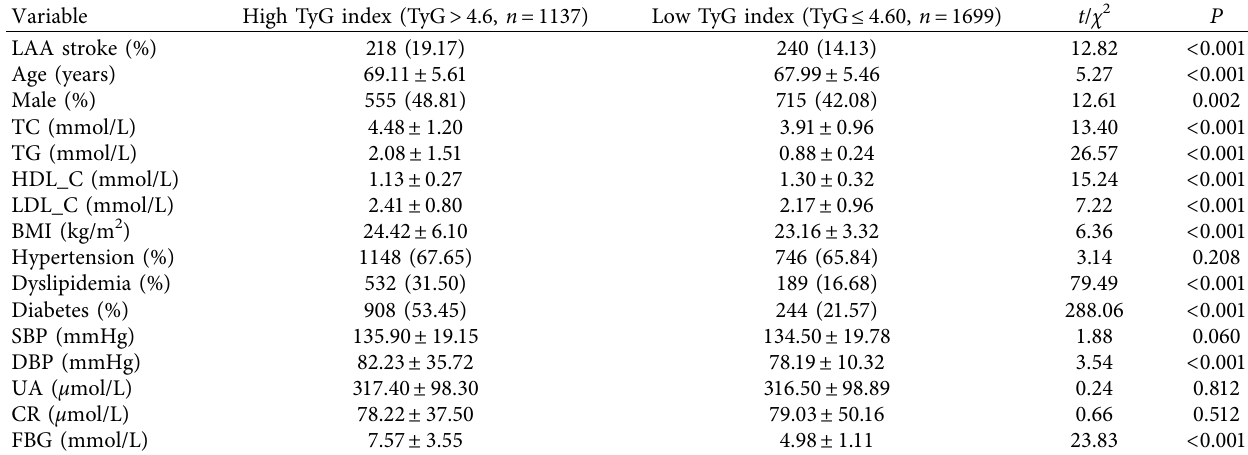
Table 3: Demographic characteristics and clinical parameters of the TyG index stratified by the most effective threshold value. Variable